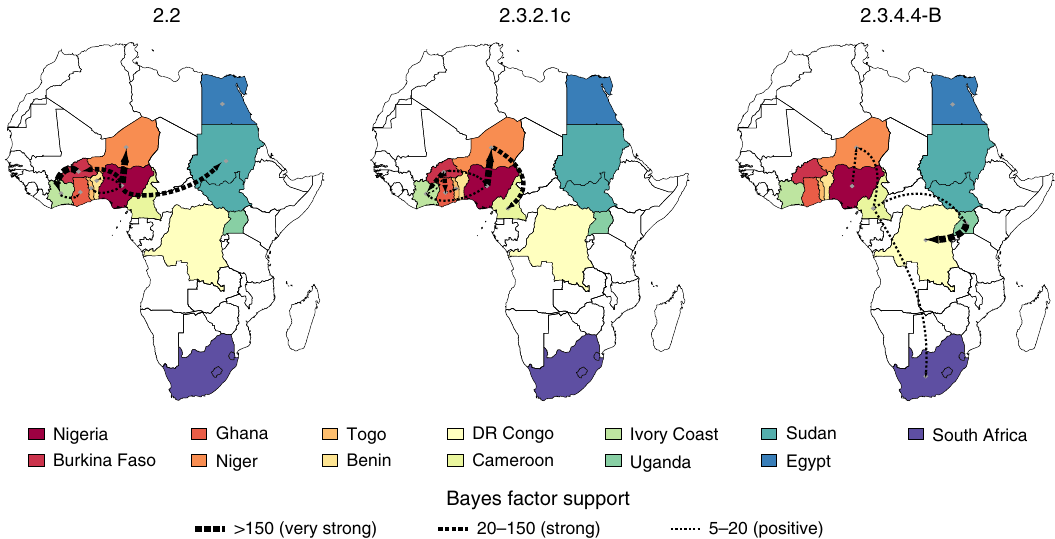
Fig. 4 Migration rates between African countries of the three HPAI H5Nx clades. Maps showing statistically supported non-zero rates (BF > 5) for clades 2.2, 2.3.2.1c and 2.3.4.4-B. Each country is labelled by the same colour used in the annotated phylogenetic trees in Supplementary Figs. 6 – 8. The thickness of the dashed lines representing the rates is proportional to the relative strength by which rates are supported for the epi-based datasets shown in the Supplementary Table 1: very strong (BF > 150, thick lines), strong (20 < BF < 150, medium lines), and positive (5 < BF < 20, thin